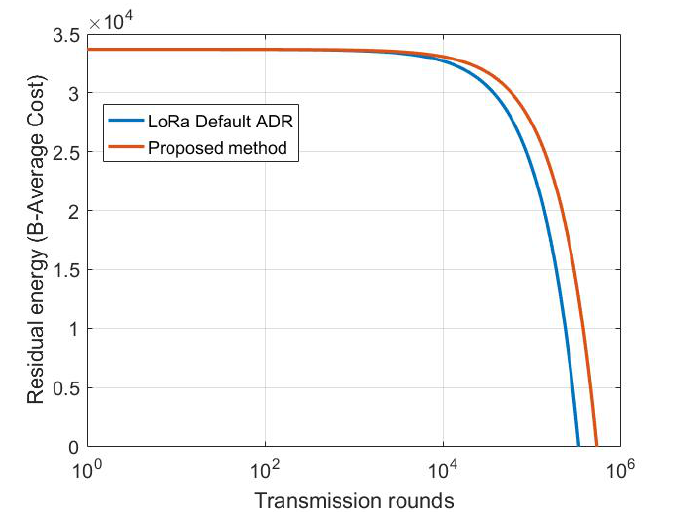
Figure 13. Residual energy variation versus distance of MDP-based model and LoRa default ADR carrying out a 30 Bytes